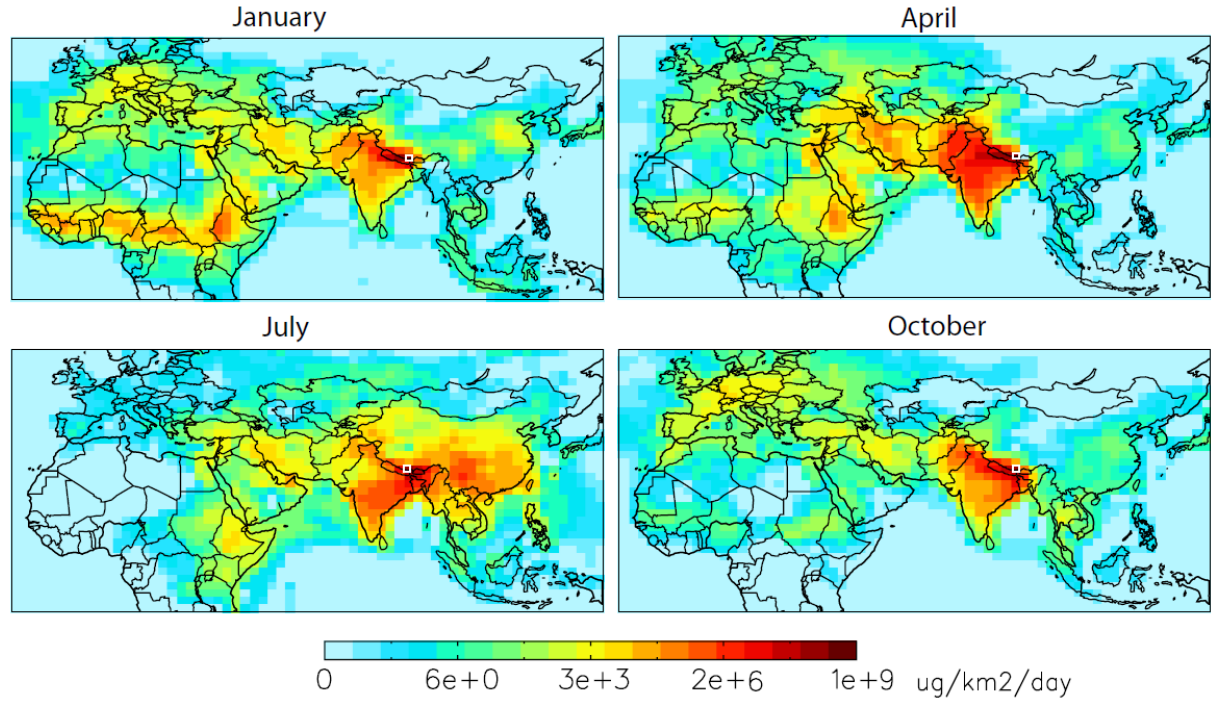
Fig. 39. Origin of black carbon by season (January, April, July, October) at Mt. Everest, as simulated with the GEOS-Chem model; the target grid box is outlined in white, and the quantity of BC deposited in the glacier grid box originating from every other grid box in the domain is indicated in color (from Kopacz et al., 2010, copyright 2010 by the European Geophysical Union, reproduced with permission).